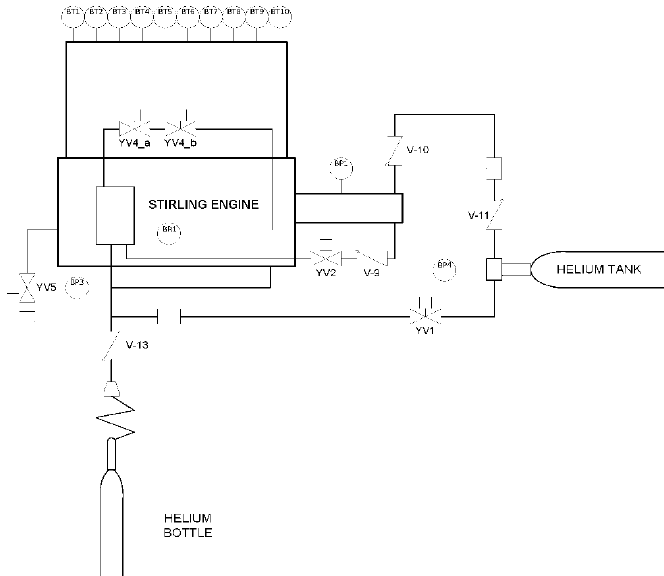
Figure 7. Main circuit of the Stirling engine. Working fluid—Helium. BT1–BT10: temperature sensors; BP1 and BP2: pressure switches; BR1: rotation sensor and generator speed sensor; BP3 and BP4: pressure transmitters.